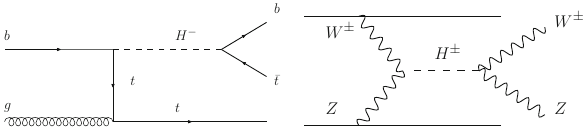
Fig. 2 The heavy charged Higgs process gb → H − t → ( ¯ tb ) t (left, charge conjugate implied) and VBF to H ± → W ± Z (right) related to the ATLAS experimental analyses at 8 TeV [25,26], used here to extract the limits on the H ± − t − b and H ± − W ± − Z couplings, respectively